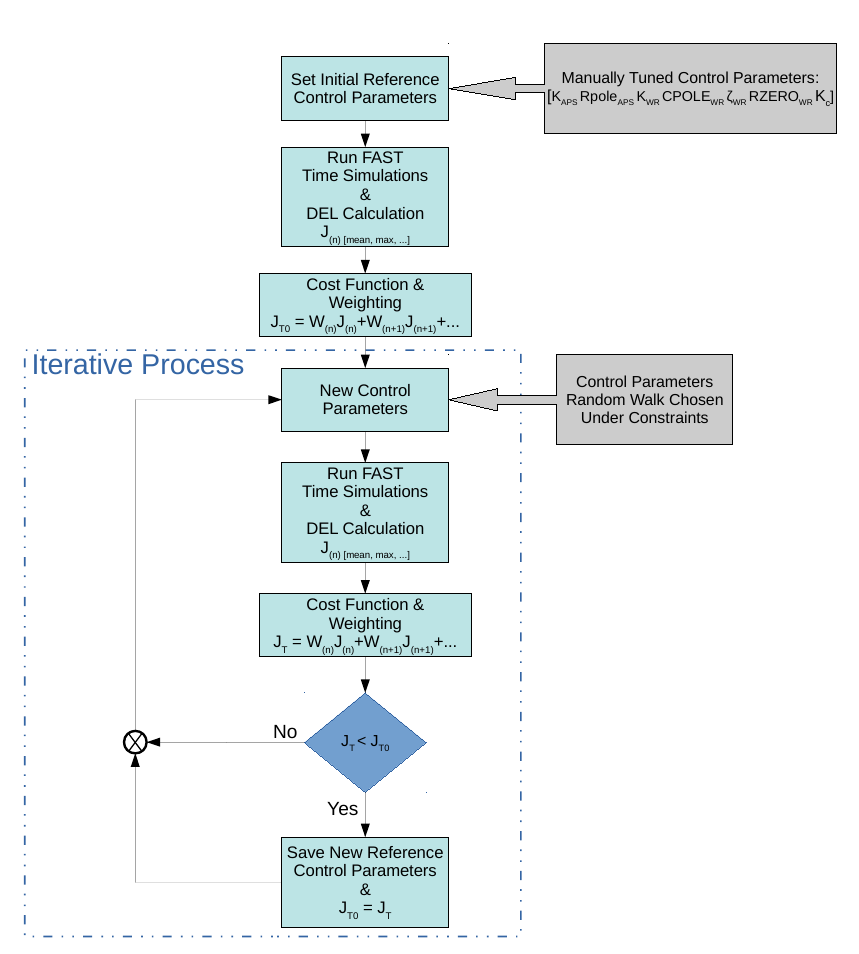
Figure 5. Process carried out for the manually tuned control parameters